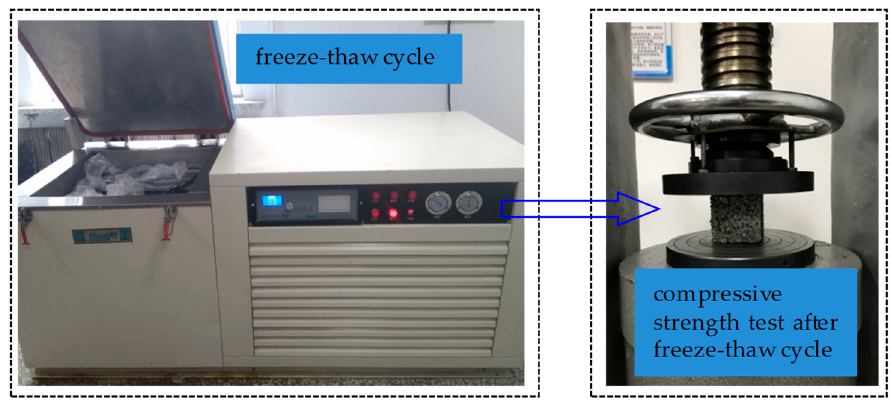
Figure 4. Freeze–thaw cycle and compressive strength test after a freeze–thaw cycle.